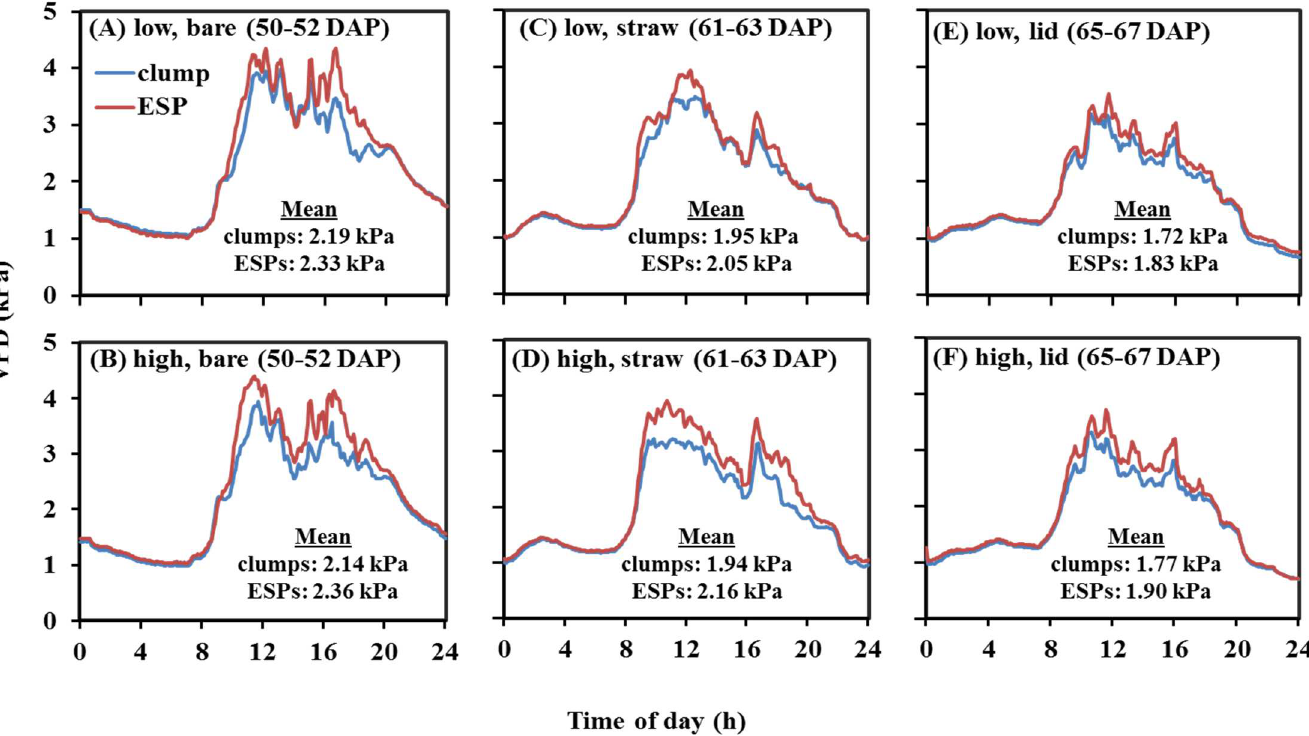
Fig 2. Average 3-day vapor pressuredeficit (VPD) mean within the plant canopy recorded everyfive minutes for different treatmentsin 2013at 50–52,61–63, and 65–67 DAP corresponding to booting, flowering, and grain formation growth stages, respectively. DAP: days after planting; ESPs: evenly spaced plantings. The mean VPD is derived from the averageof 2592 data points.